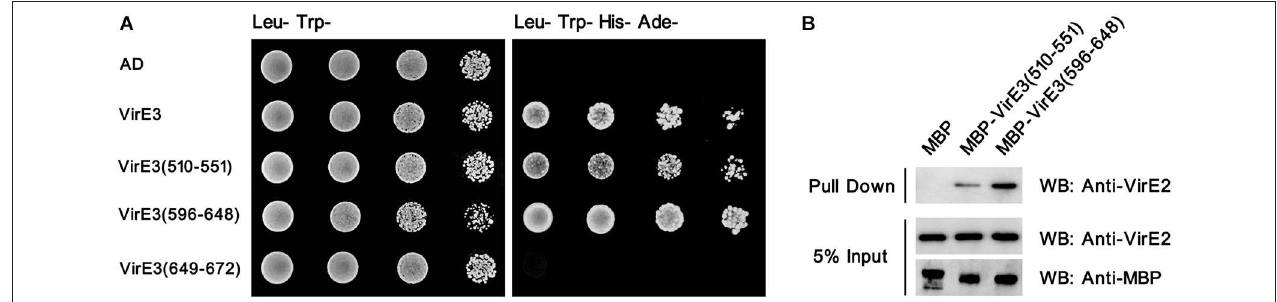
FIGURE 3 | The two conserved domains at the C-terminus of VirE3 interact with VirE2 in vitro . (A) Yeast two-hybrid assay for VirE2 and VirE3. The C-terminal parts of VirE3 containing the putative VirE2-interacting domain A (amino acids 510-551), VirE2-interacting domain B (amino acids 596–648) and the secretion signal (amino acids 649-672) were cloned into pGADT7 (AD). The AD constructs were co-transferred into yeast strain AH109 together with pGBKT7-VirE2. The transformed cells were grown on SD medium minus tryptophan and leucine (Leu-Trp-), and SD medium minus tryptophan, leucine, histidine and adenine (Leu-Trp-His-Ade-). The empty AD or pGADT7-VirE3 was used as the negative or positive control, respectively. (B) Maltose-binding protein (MBP) pull-down assays for VirE2 and VirE3. MBP-tagged VirE2-interacting domain A or VirE2-interacting domain B was used as a bait and VirE2 was used as a prey. MBP alone was used as the control. Protein detections were carried out by western blots (WB) using antibodies as